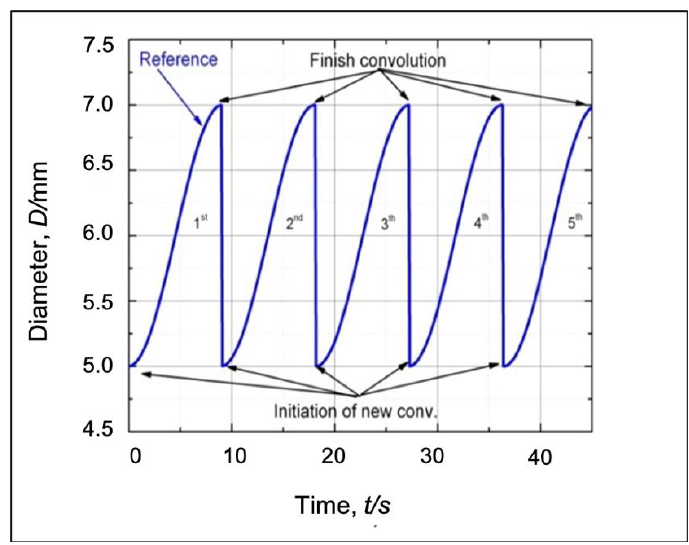
Figure 15. Diameter reference used in the semi-dieless bellows forming with vision-based fuzzy control.